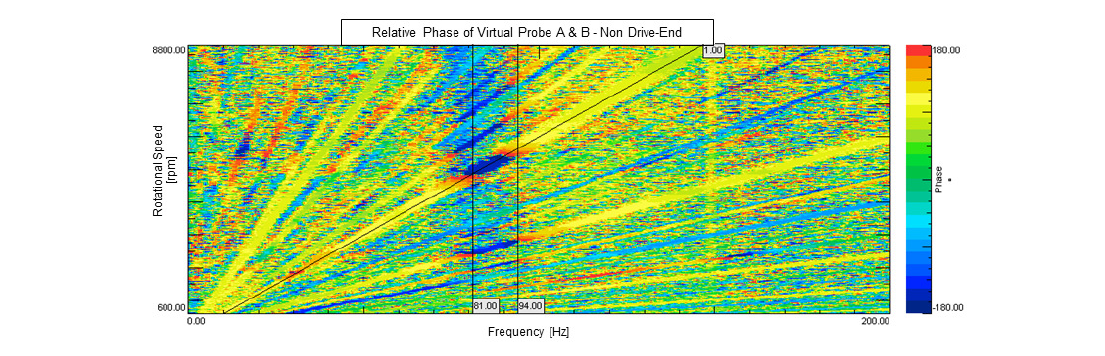
Figure 11. Orbital relative phase plot between Virtual Probes A and B.